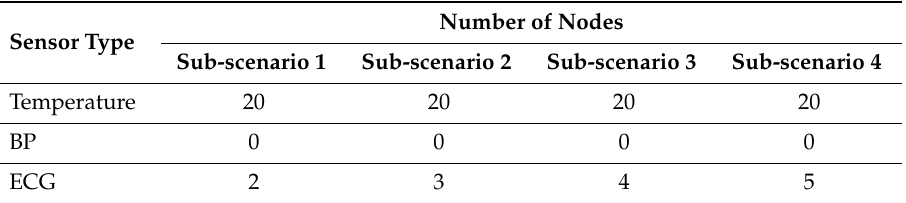
Table 5. Deployment of sensors in Scenario 2.